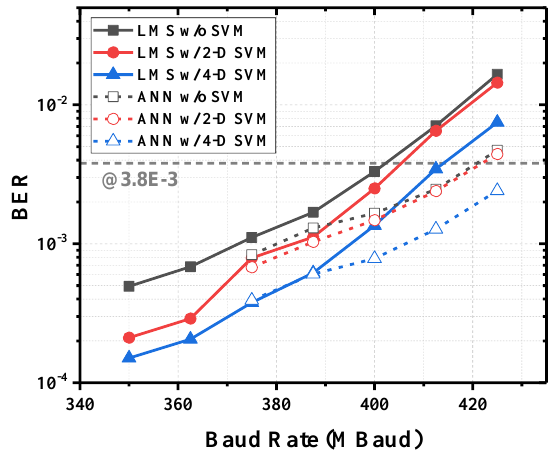
Figure 9. BER versus Baud rate with hard decision and SVM-based soft decision.